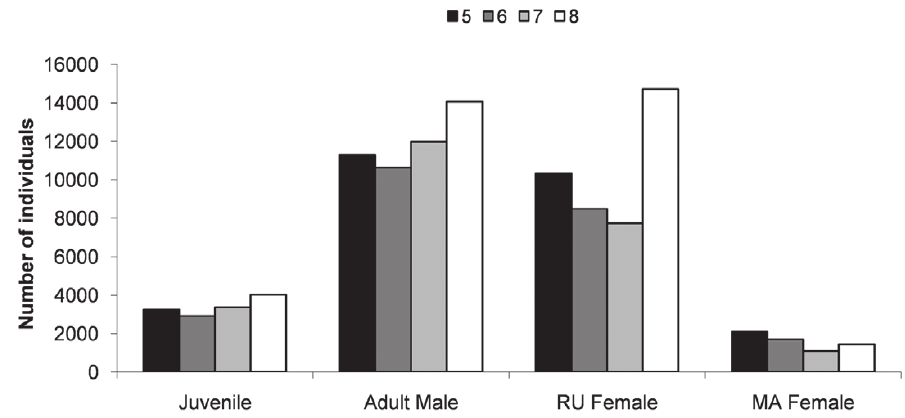
Fig. 5 - Number of individuals of Xiphopenaeus kroyeri in each demographic category sampled in locations 5 to 8 of the Santos Bay, from May 2008 through April 2010 (RU= adult females with rudimentary ovaries; MA= reproductive